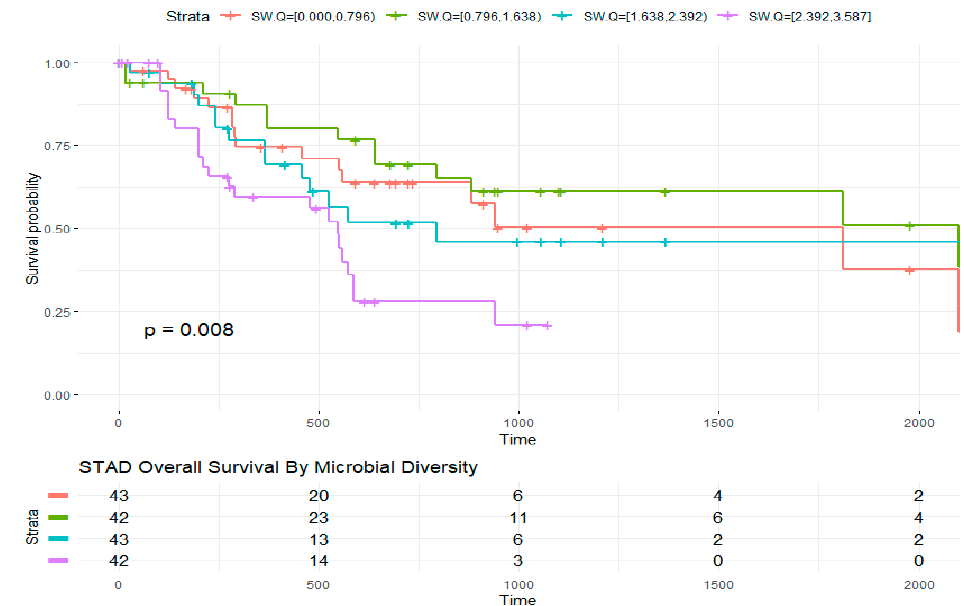
Figure 5. STAD overall survival by microbial diversity. The survival curve (created with survminer) for the relationship between within-sample bacterial diversity and overall survival with global p -value ( p = 0.008) is shown. Strata with risk set size are shown in table. Time in days survived after diagnosis or days to last follow up (censored). Censoring over time are delineated by “+” within the survival lines for each strata.